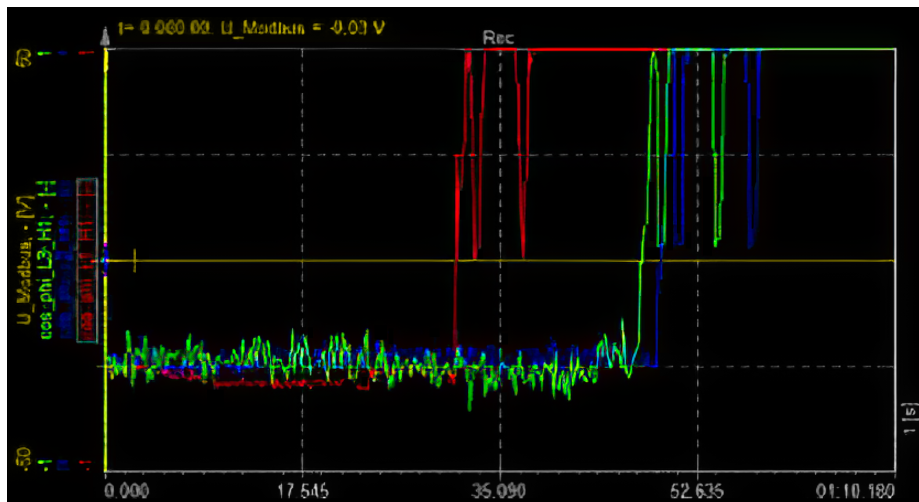
Figure 12. Startup for 3 phases (II).